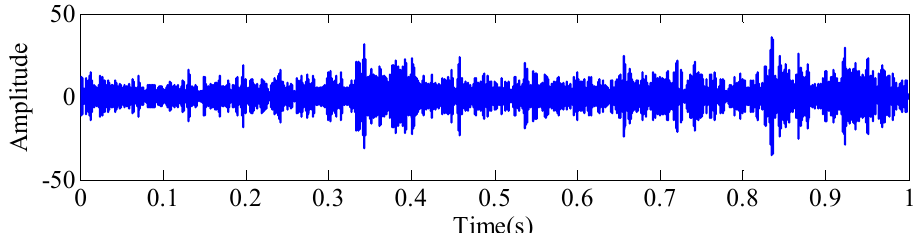
Figure 21. Noise reduction diagram of the randomly selected signal segment.